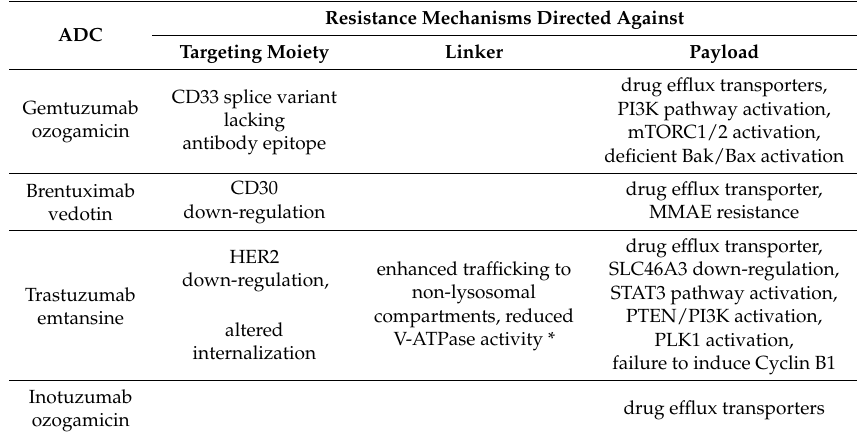
Table 1. Documented resistance mechanisms for FDA-approved antibody-drug conjugates